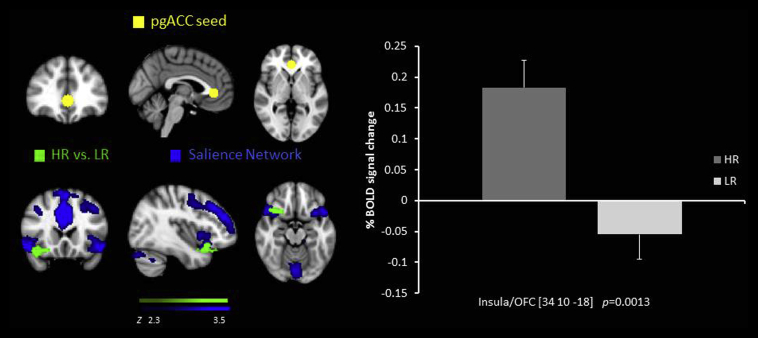
Resting state functional connectivity between the pgACC seed region  and the insula/LOFC, higher in the HR group than the LR  overlaid on the Salience Network . % BOLD signal change extracted for connectivity for both of the groups.